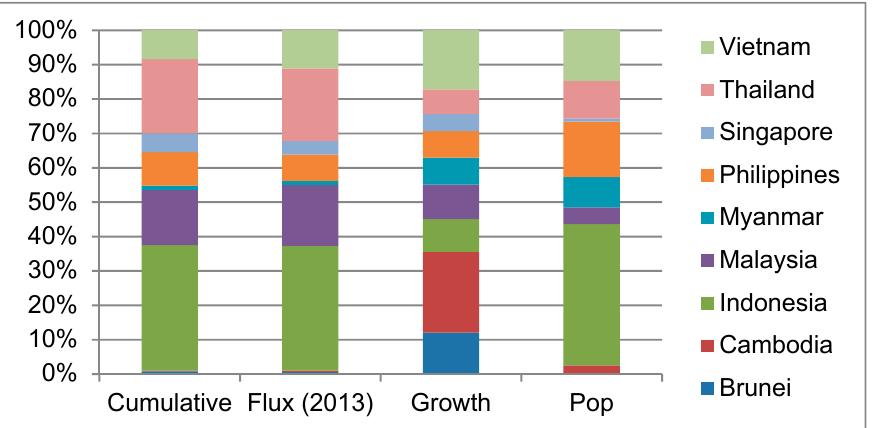
Figure 5. Relative contributions of nine ASEAN countries (except Laos PDR) to cumulative ASEAN